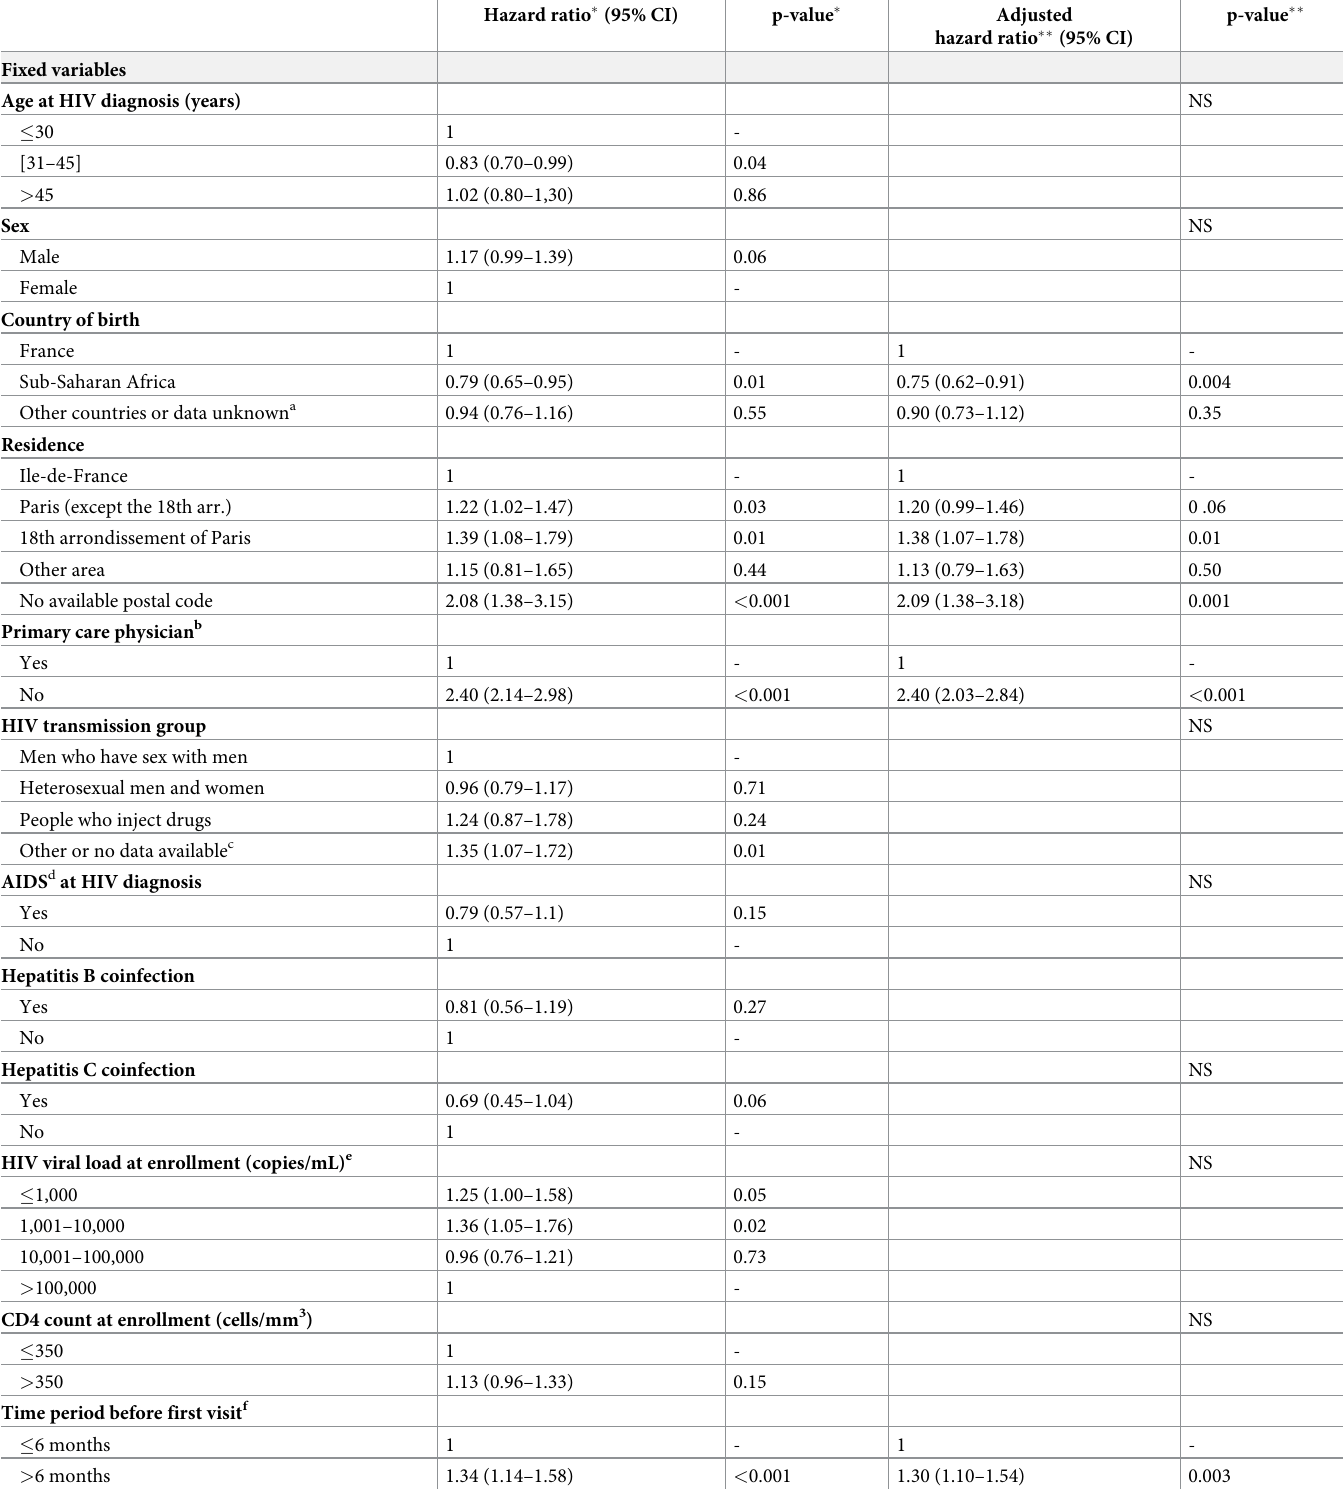
Table 2. Univariate and multivariate analysis of factors associated with Medical Care Interruption (MCI) at the time of HIV diagnosis and during follow-up of patients seeking HIV Care in the infectious diseases department of Bichat hospital, Paris, between January 2010 and May